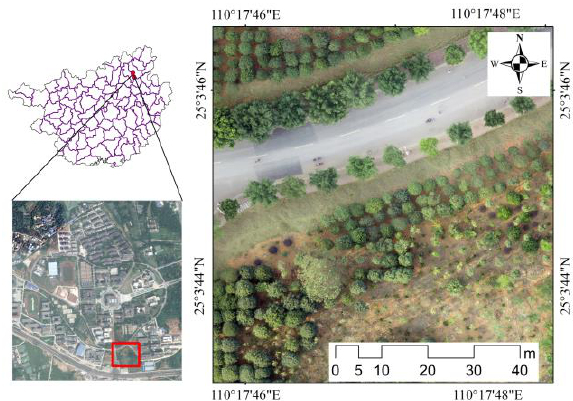
Figure 1 . The location of the study area. The red rectangle illustrates the coverage of study area.